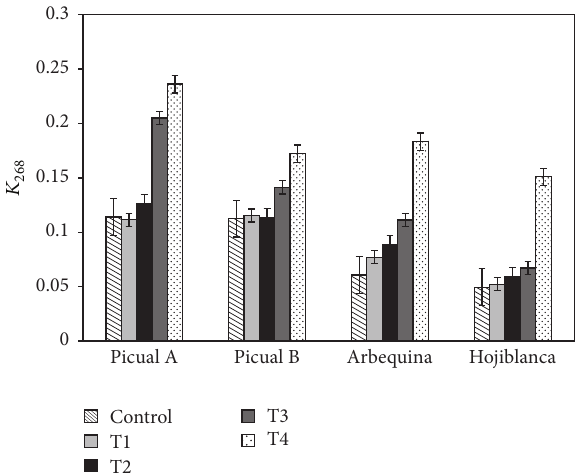
Figure 1: Influence of the heating treatments on the peroxide value of the olive oils.